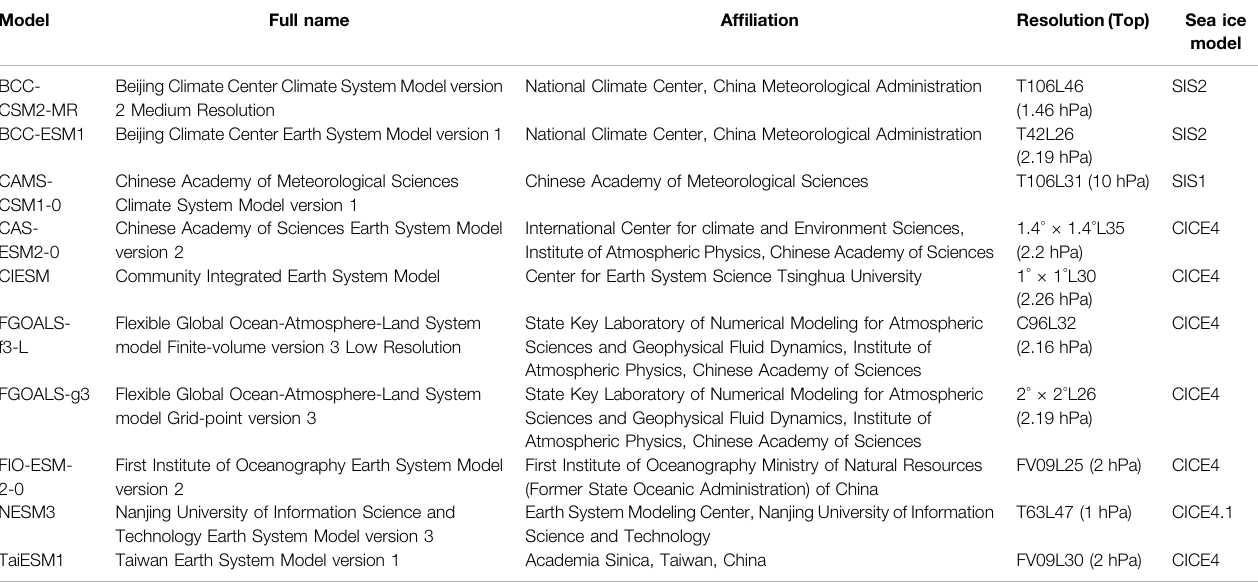
TABLE 1 | Ten Chinese CMIP6 models tested in this study. The historical run is commonly available for the ten